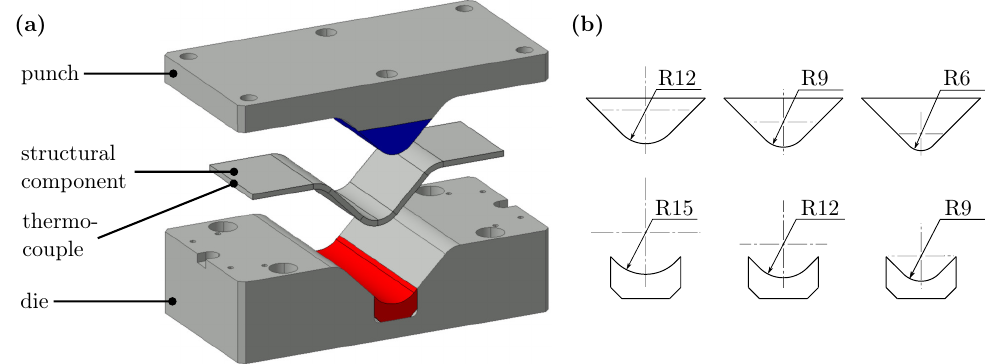
Figure 2. Forming tool and structural component specimen: ( a ) setup of the forming tool with inserted structural component, thermocouple and modular exchangeable radius punches (blue) and dies (red); ( b ) modular exchangeable radius punches and dies of the respective structural component